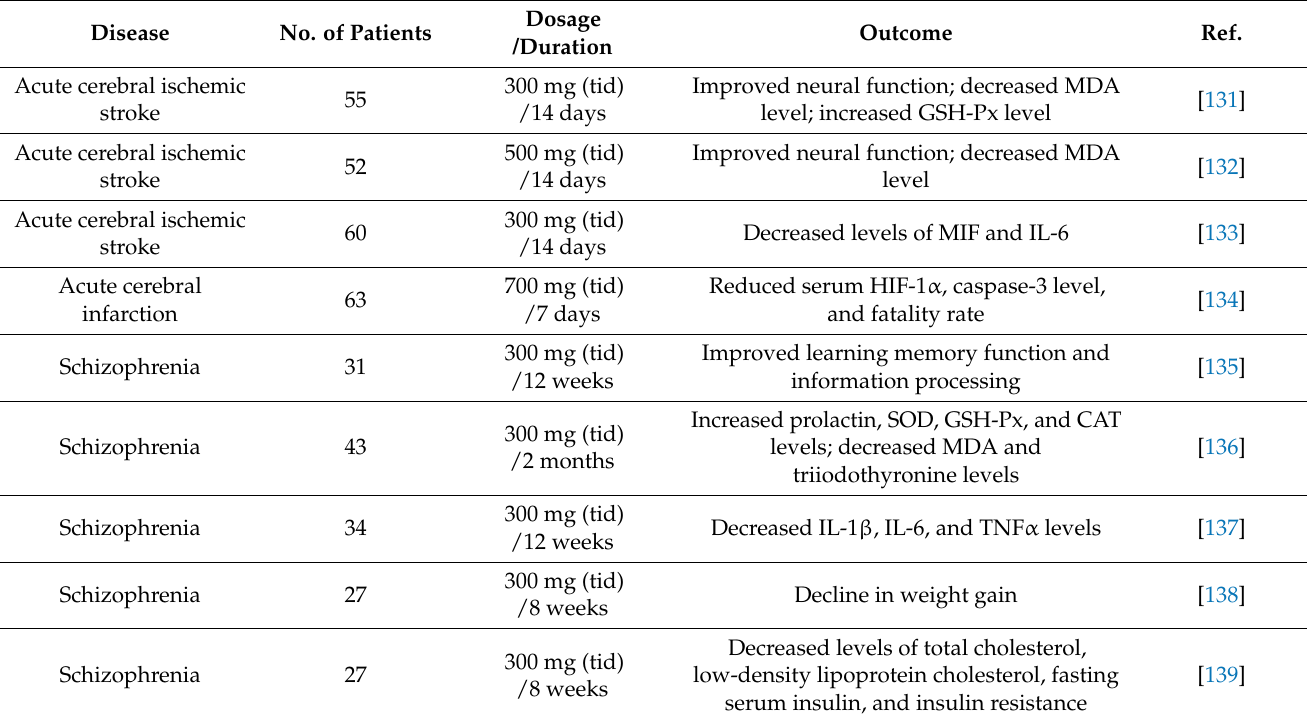
Table 1. Clinical trials of BBR on stroke and schizophrenia